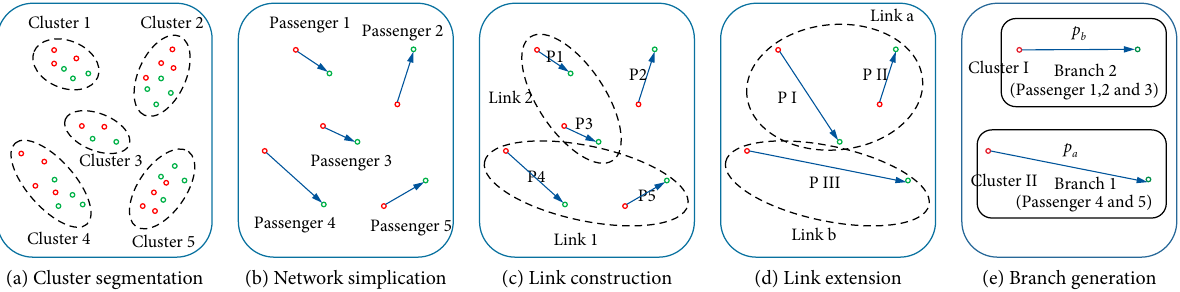
network.Figure 4: A paradigm of cluster